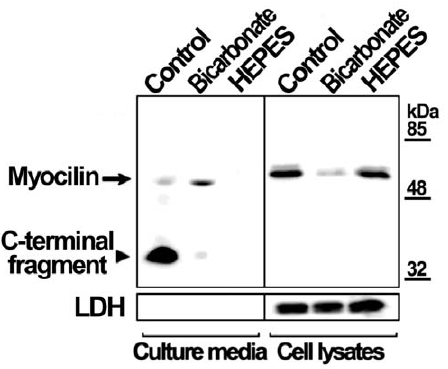
Figure 11. Effect of extracellular bicarbonate on full-length myocilin secretion. HEK-293T cells (500000 cells/well in 24-well plates) were transfected with a cDNA construct encoding myocilin-myc. After transfection cells were cultured in 200 ul of bicarbonate buffered medium for 39 h (control). Other cells were cultured in the same medium for 36 h, then the culture medium was removed and the cells were incubated with either fresh bicarbonate-buffered medium (bi- carbonate) or HEPES-buffered medium (75 mM, pH 7.1) (HEPES) for 3 h. Cell lysates samples contained 20 m g of total protein. Bicarbonate- buffered medium and HEPES-buffered medium aliquots contained 80 and 2 m g of total protein, respectively. Extracellular and intracellular recombinant myocilin and LDH were analyzed by 10% polyacrylamide SDS-PAGE and Western blot using anti-myc or anti LDH monoclonal antibodies, respectively. The experiment was repeated three times independently.